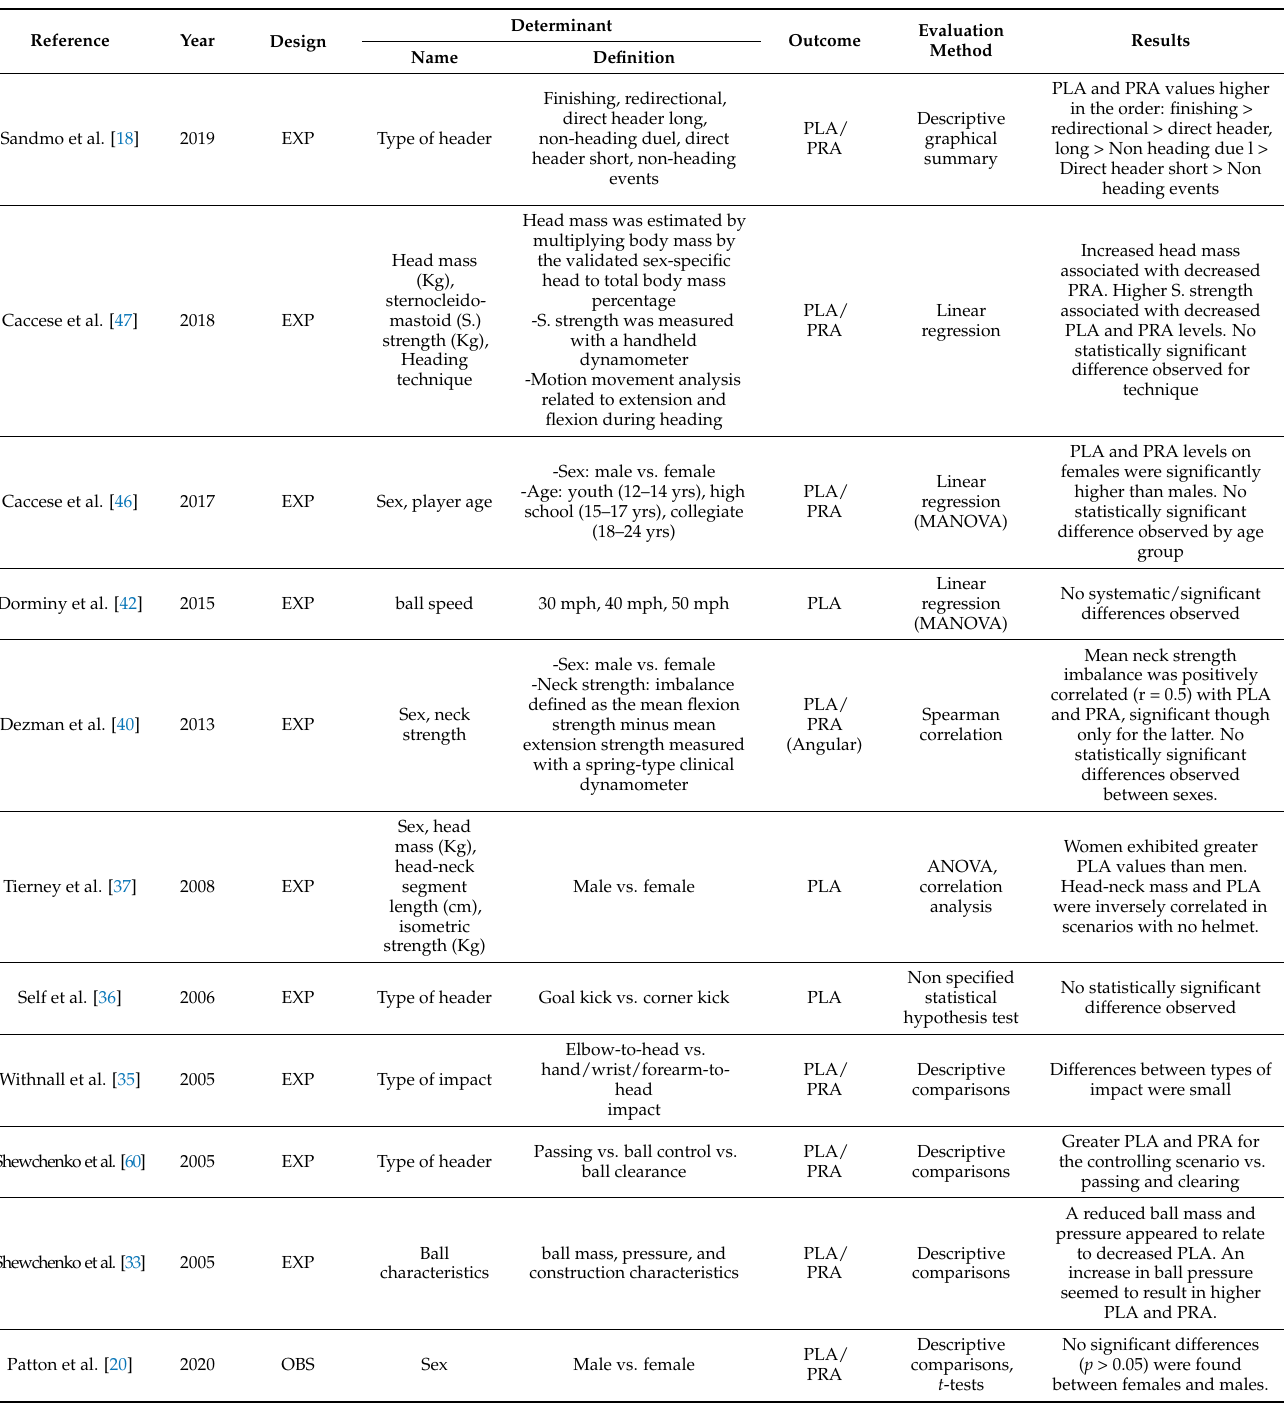
Table 3. Summary of studies reporting the effects of potential determinants of the acceleration of